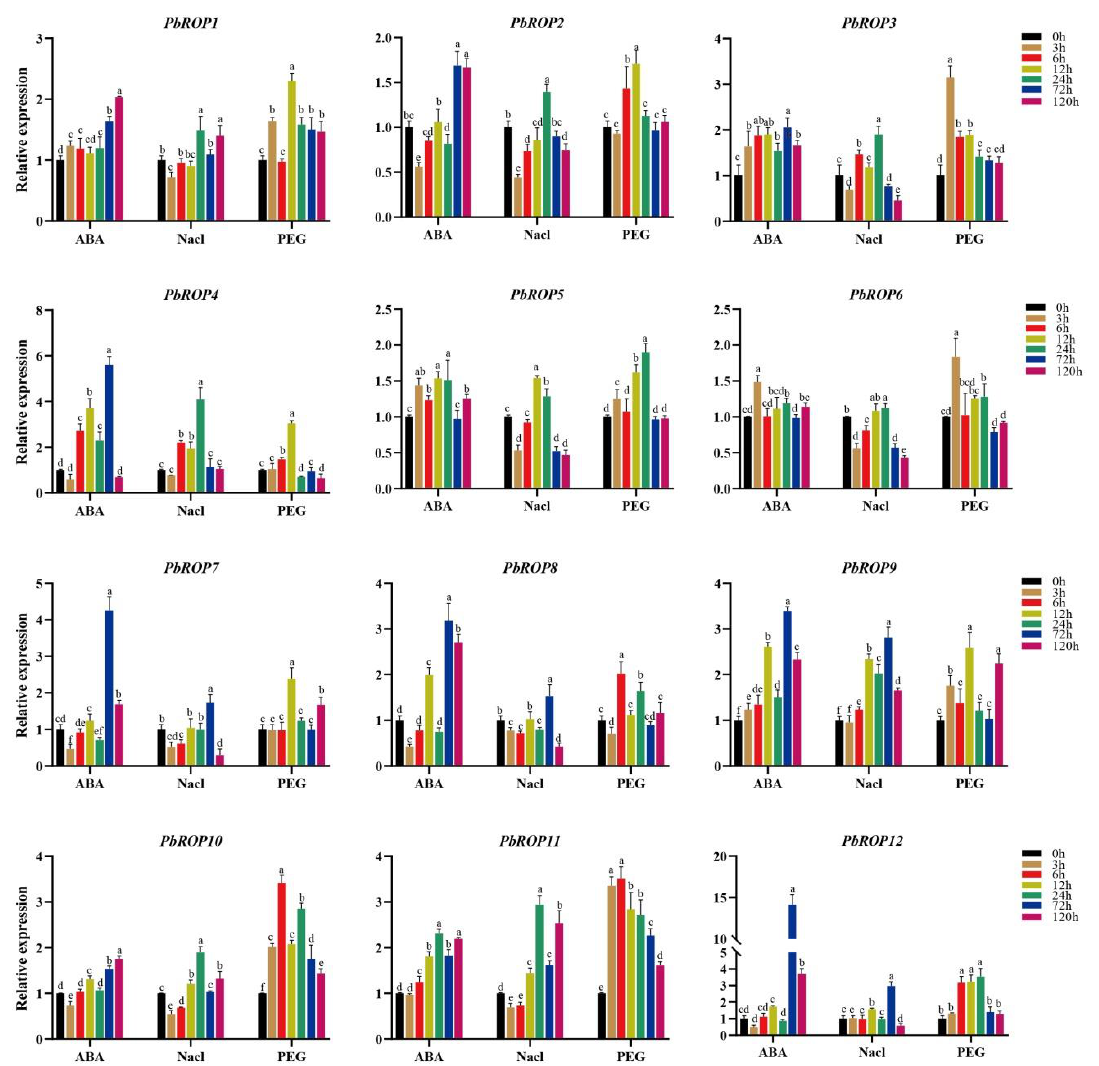
Figure 8. Expression profiles of PbROPs in tissue-cultured ‘ Duli ’ pear seedlings treated with 1 µ M ABA, 150 mM NaCl, and 20% PEG. The relative expression levels of PbROPs at 5 different time points were monitored by real-time RT-PCR. PbACTIN was used as the reference gene. The relative expression level of each gene was calculated relative to the transcript level at the start of treatment (0 h) (set as 1). Each bar represents the mean ± SE (n = 3). The chart was constructed using GraphPad Prism (8.0.2, Harvey Motulsky, California, USA) software. Different letters on top of the columns indicate significant differences at p < 0.05 (n = 3) using Duncan’s multiple range test by the SPSS (25.0, IBM company, New York, USA) software.